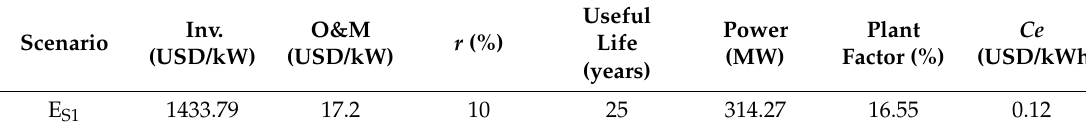
Table 12. The cost of energy produced by solar PV systems.